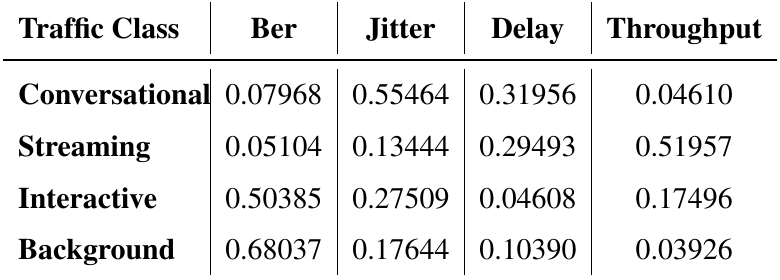
Table 3. Importance Weights Per